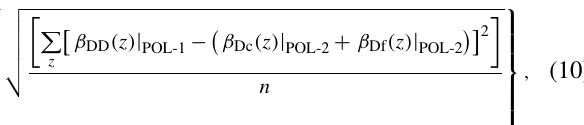
profile. For comparison between Fig. 2a and b, differences 4.5 km in height, as derived from either POL-1 or